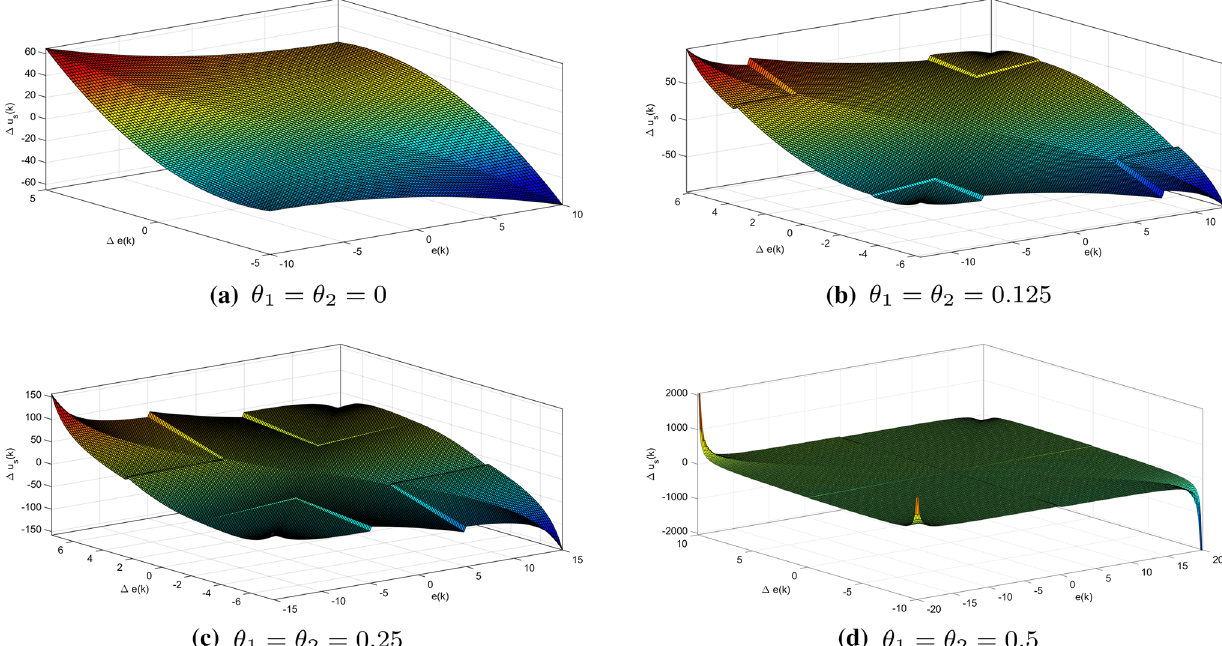
Fig. 8 Control surface plots with varying